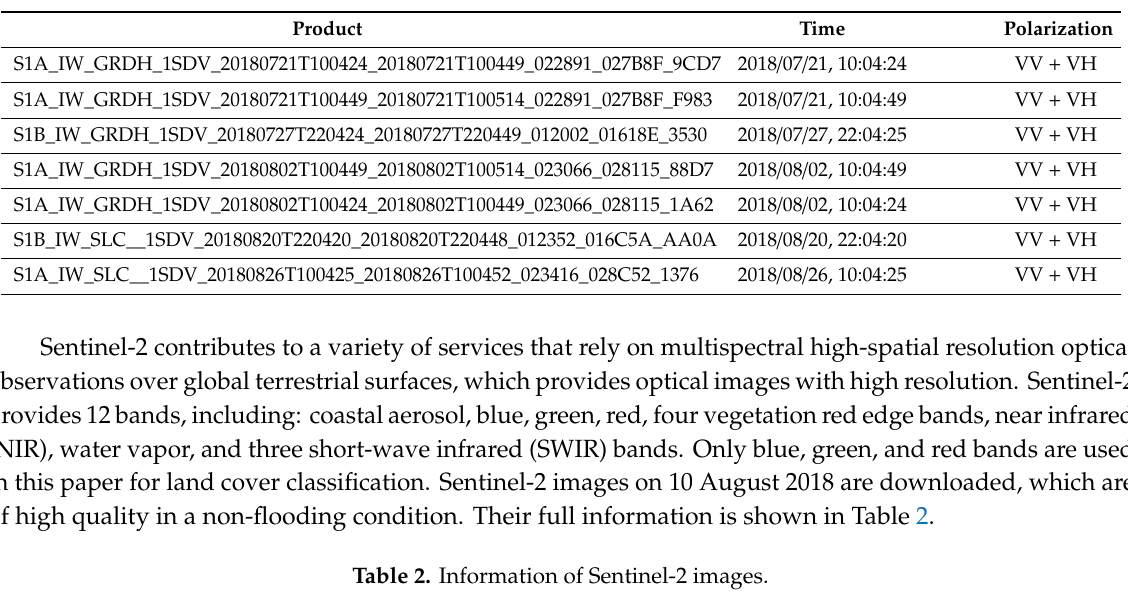
Table 1. Information of Sentinel-1 ground range detected (GRD) products.